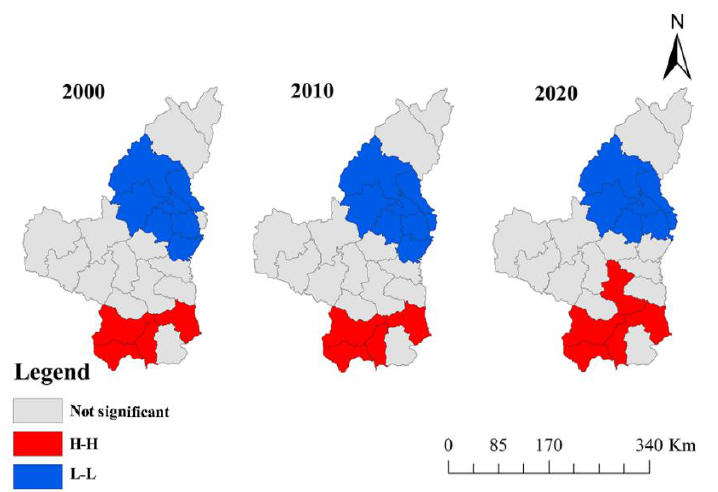
Figure 7. LISA aggregation map of the ESV per unit area in the 25 districts and counties in the Loess Plateau of Northern Shaanxi.